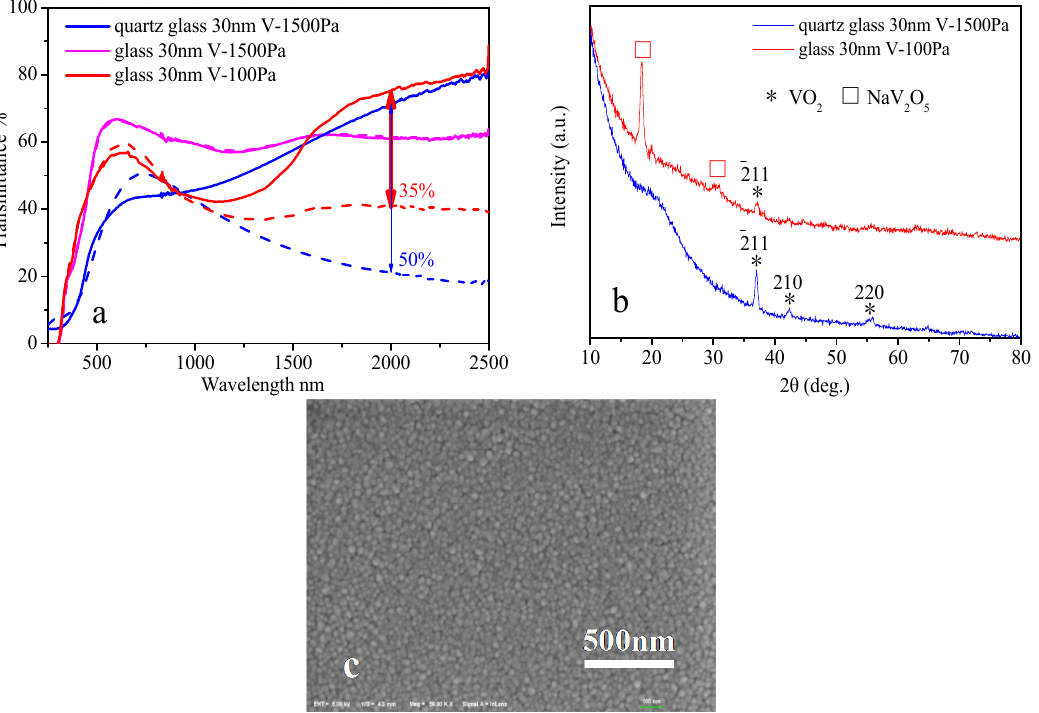
Figure 9. Transmittance curves (solid line: 20 °C, dash line: 90 °C) ( a ), XRD patterns ( b ) of VO 2 films prepared by professional annealing of 30 nm V metal films on two contrastive substrates of quartz glass and float glass at set pressures, 400 °C for 1 h; and SEM image ( c ) of the VO 2 film from “quartz glass 30 nm V-1500 Pa”.